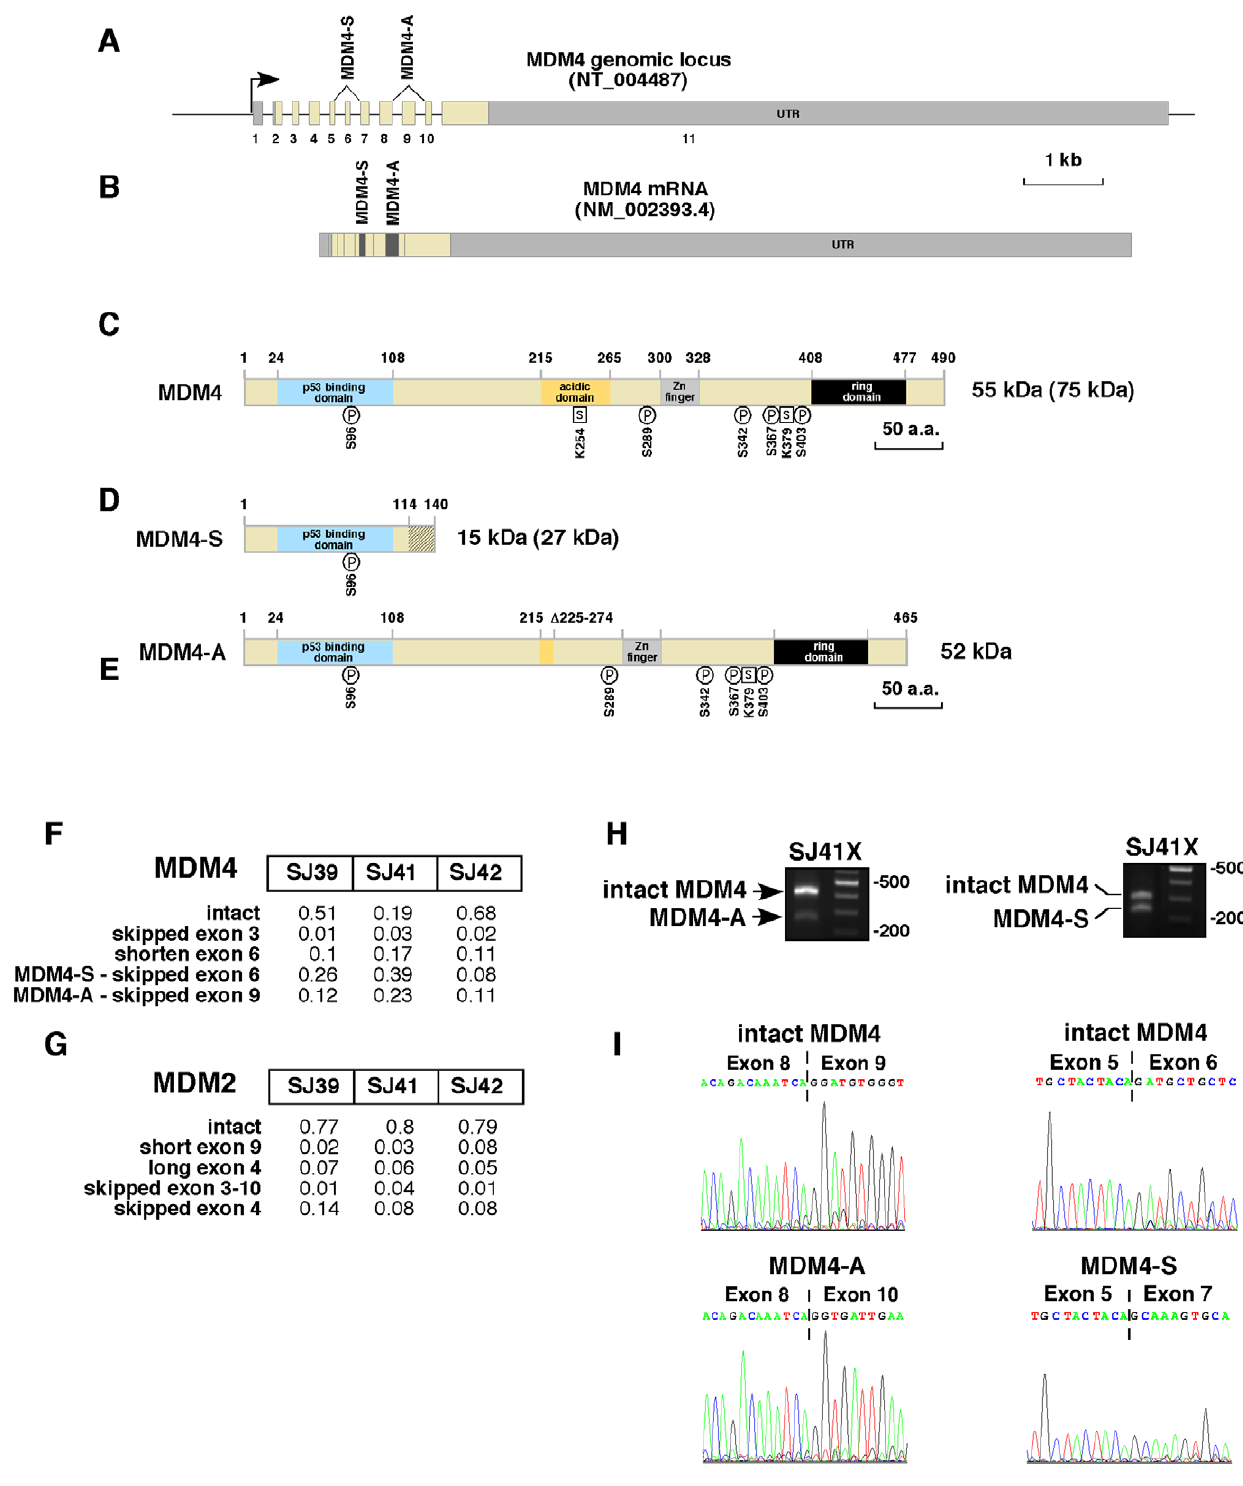
Figure 3. Analysis of transcript variants of MDM4 in retinoblastoma. A, B ) Genomic organization of MDM4 showing two previously identified splice variants for this gene and the corresponding mRNA. MDM4-S results from skipping of exon 6 and MDM4-A results from skipping of exon 9 (dark gray shading). ( C ) Domain structure of the full length MDM4 protein with known protein modification sites (phosphorylation (P) and sumoylation (S)) ([18]). The predicted size is 55 kDa with an observed size on SDS-PAGE of , 75 kDa. ( D ) The loss of exon 6 in MDM4-S results in a frameshift after residue 114 and a translational termination after residue 140 (diagonal line). The predicted size of MDM4-S is 15 kDa and the observed size on SDS-PAGE is 27 kDa [18,27]. ( E ) The loss of exon 9 in MDM4-A results in an in frame fusion that is missing 50 residues spanning a portion of the acidic domain. ( F ) Representative reads from transcriptome analysis showing the loss of exon 6 and exon 9 in the retinoblastoma